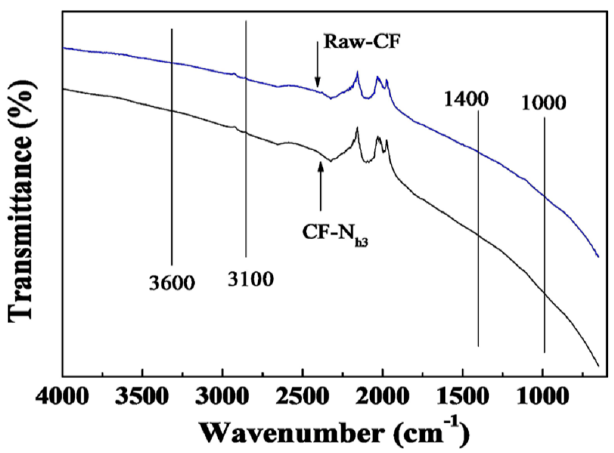
Figure 2. FTIR spectrum of Raw-CF and CF-N h3 .